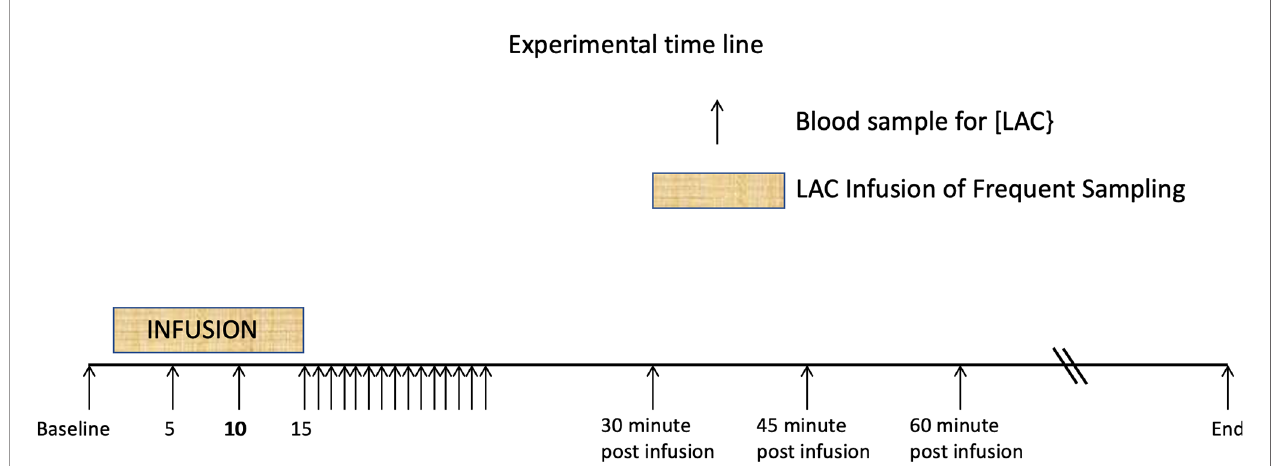
FIGURE 1 | Time line showing 15 minute periods one of L-Lactate infusion, and the other of rapid sampling. These are followed by the postinfusion sampling strategies. Additional samples were drawn until the baseline lactate was reached. From Figure 1 from P De Pedro et al. J. Vet. Emerg. Crit. Care 22 (5)2012. pp 564- 572